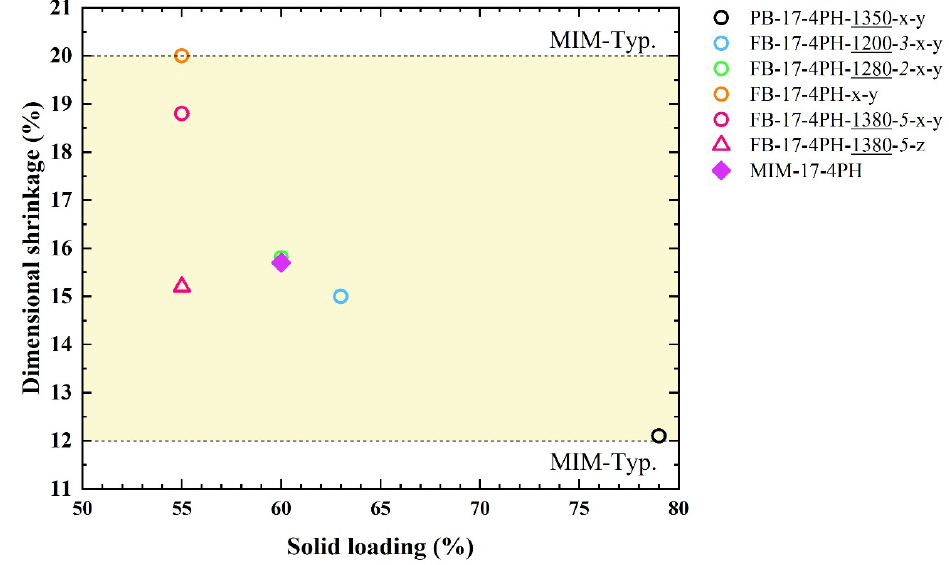
Figure 15. Solid loading vs. dimensional shrinkage map of 17-4PH stainless steel fabricated by metal MEX process with different conditions compared with typical MIM. The underlined number represents sintering temperature ( ◦ C); the italic number represents sintering time (h); and x-y (average from length and width) or z (thickness) indicate the direction of shrinkage measurement. Data from [8,36,44,49,64,127,158].